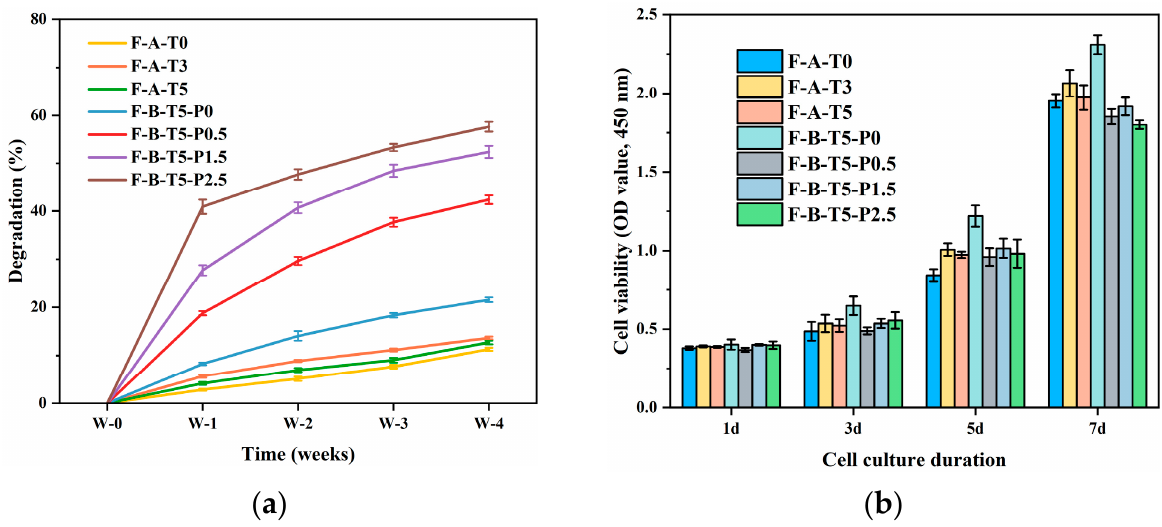
Figure 6. ( a ) Degradation and ( b ) CCK ‐ 8 assay of F ‐ A ‐ T0/T3/T5 and F ‐ B ‐